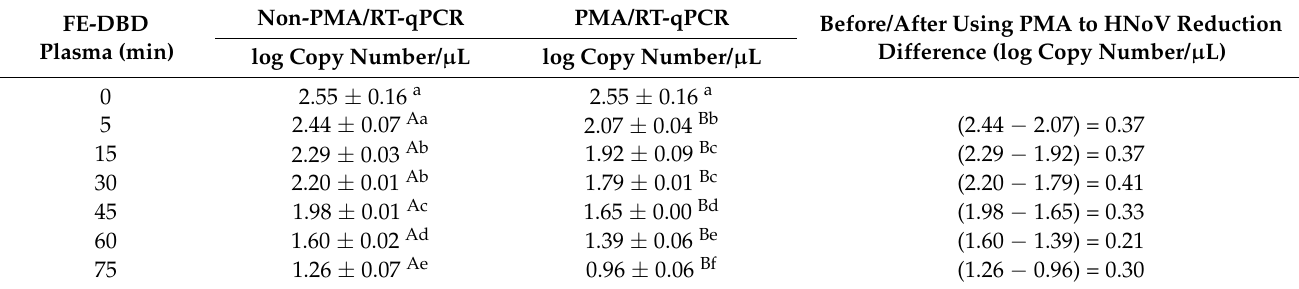
Table 2. Effect of FE-DBD plasma treatment against HNoV GII.4 spiked on sea squirt.